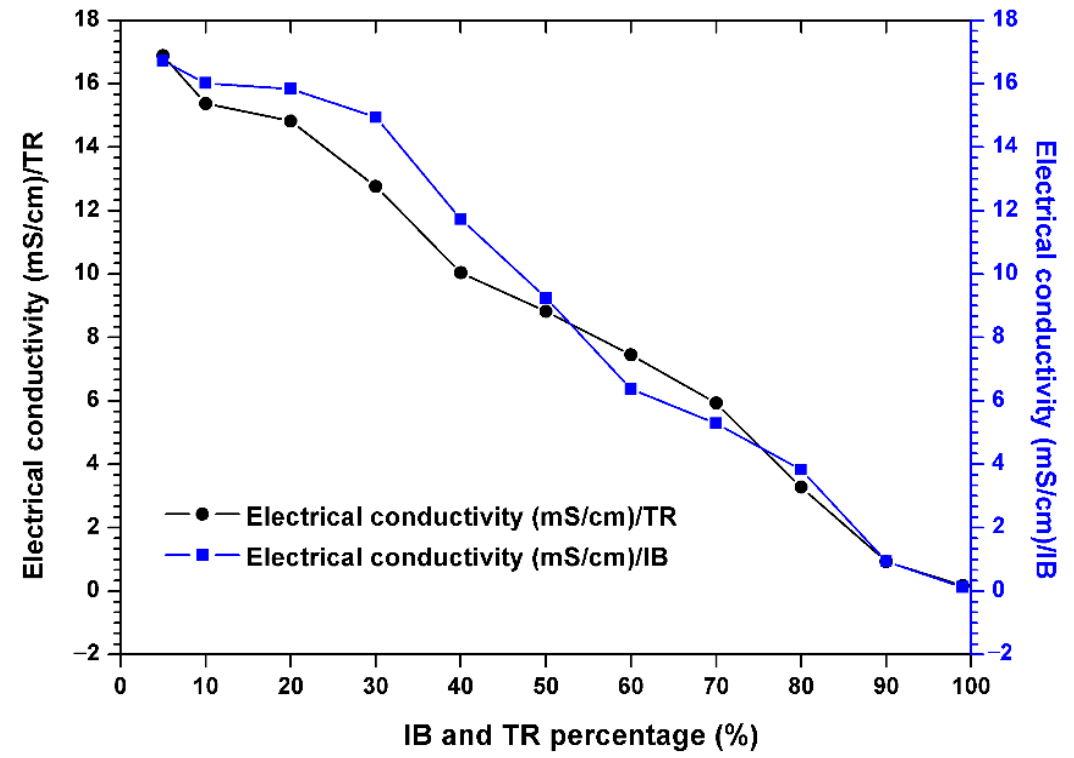
Figure 4. Evolution of the electrical conductivity of the margin–bentonite mixtures.